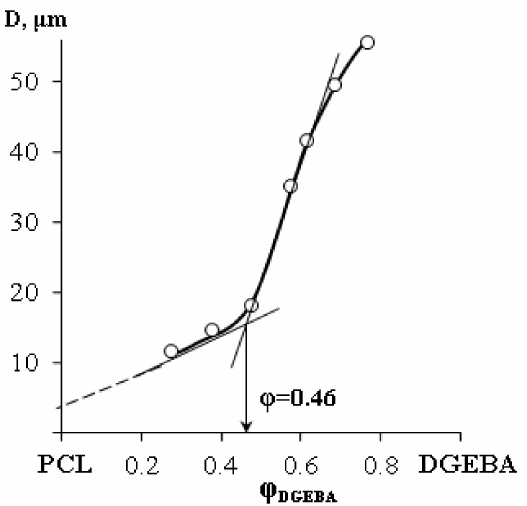
Figure 8. The concentration dependence of the size of crystalline formations in PCL–DGEBA